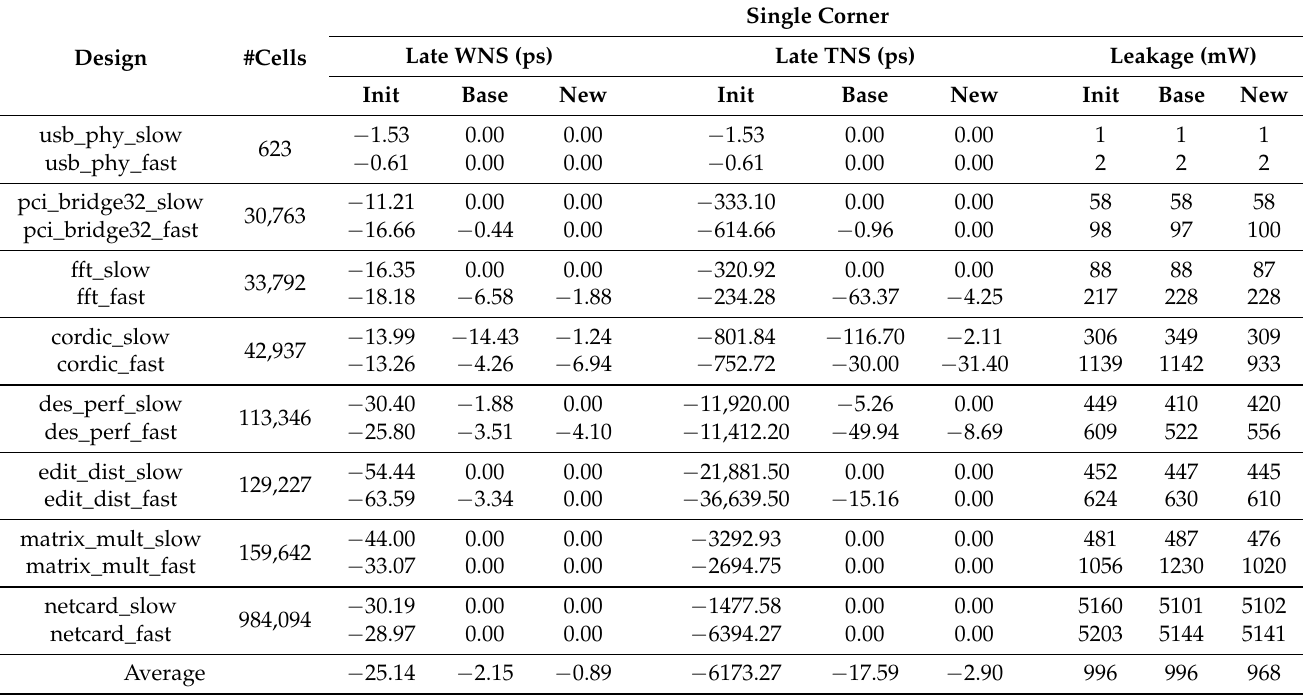
Table 1. Timing and leakage power of all designs under single corner initially (Init) and at end of incremental LR-based sizer without (Base) and with (New) proposed LM initialization.